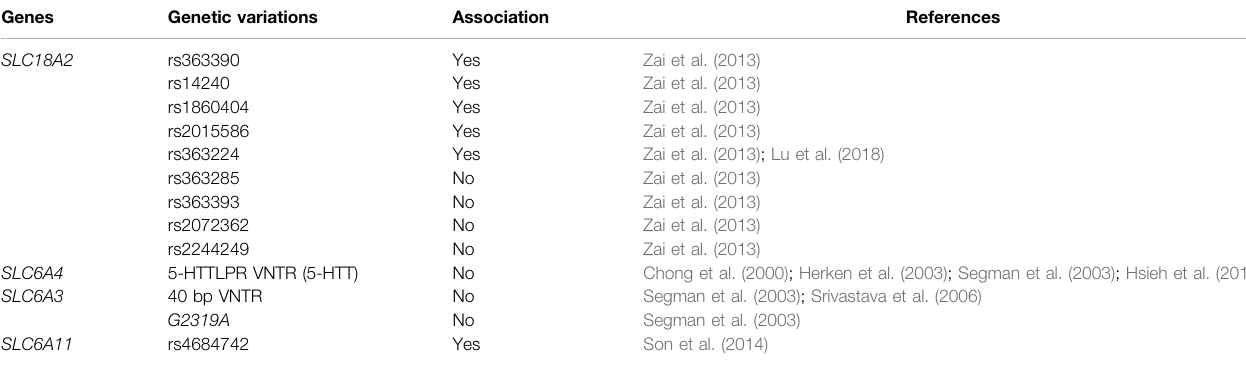
TABLE 5 | Genetic variability of neurotransmitter transporters and its associations with TD.